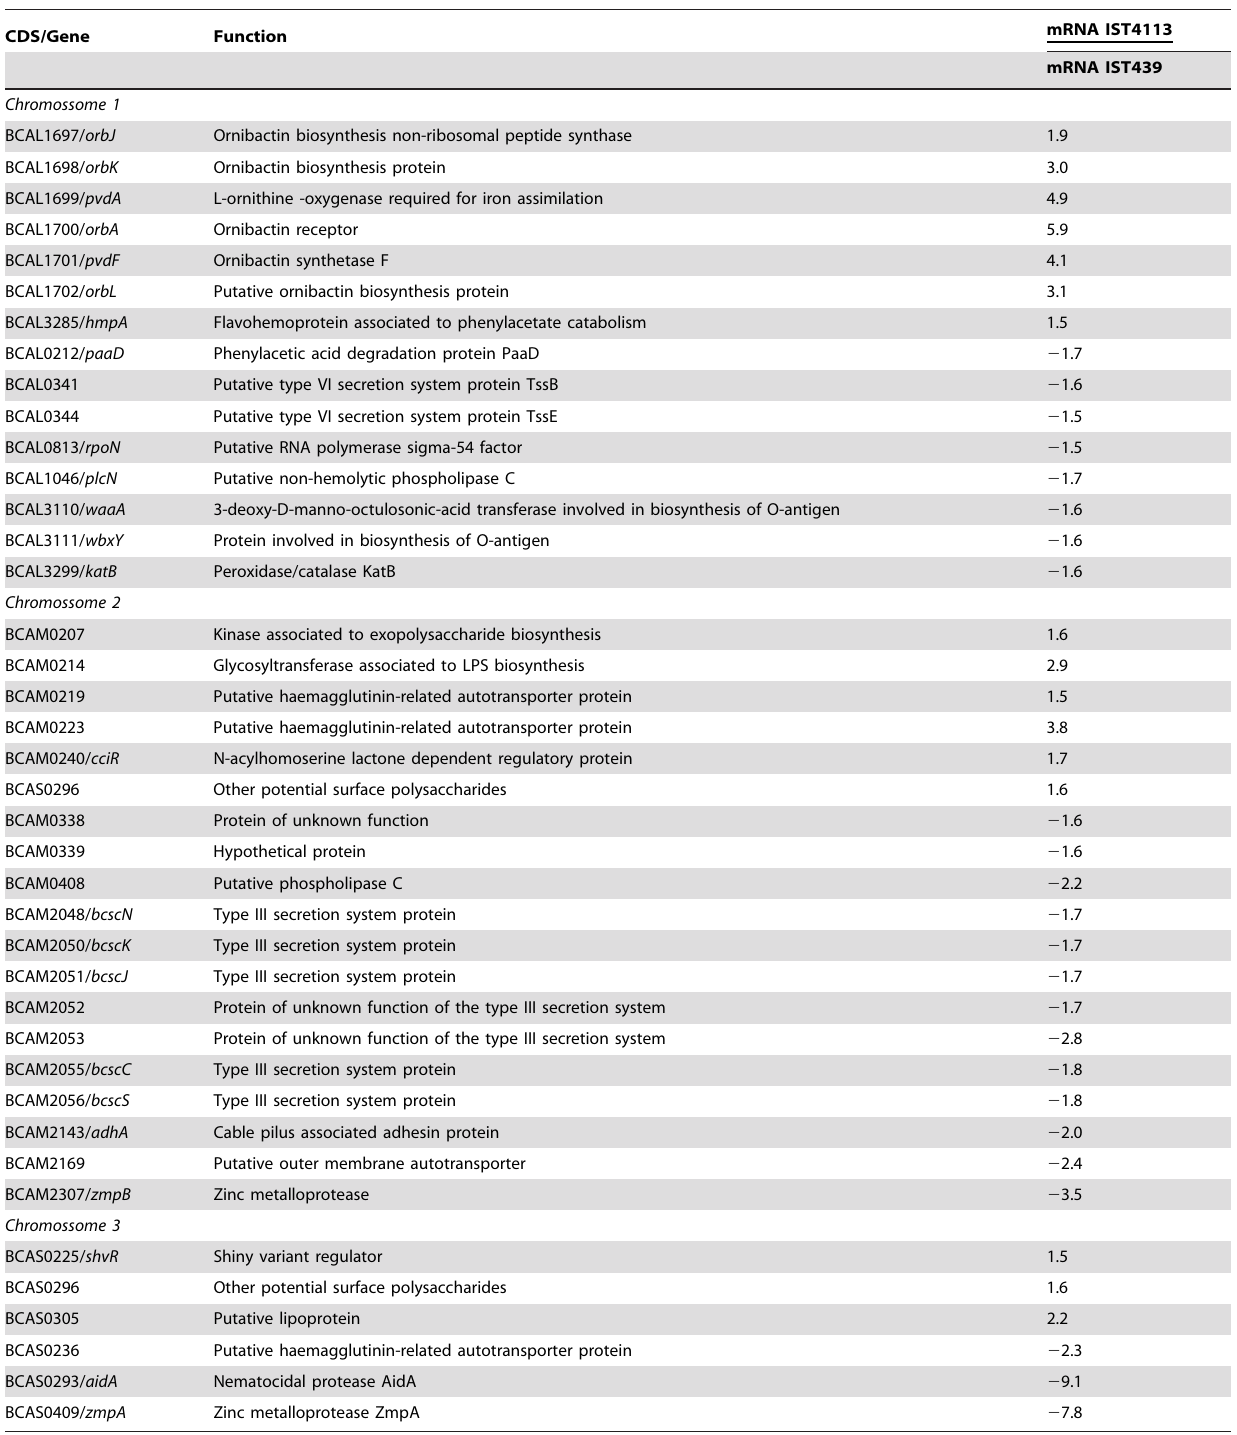
Table 3. B. cenocepacia virulence determinants differently expressed in IST439 and IST4113.